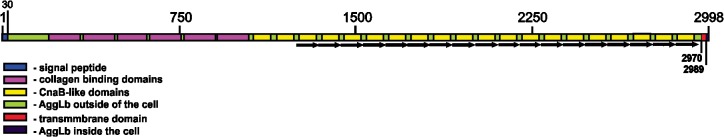
Schematic representation of AggLb protein.Boxes indicate domains of protein. Arrows indicate repeats.